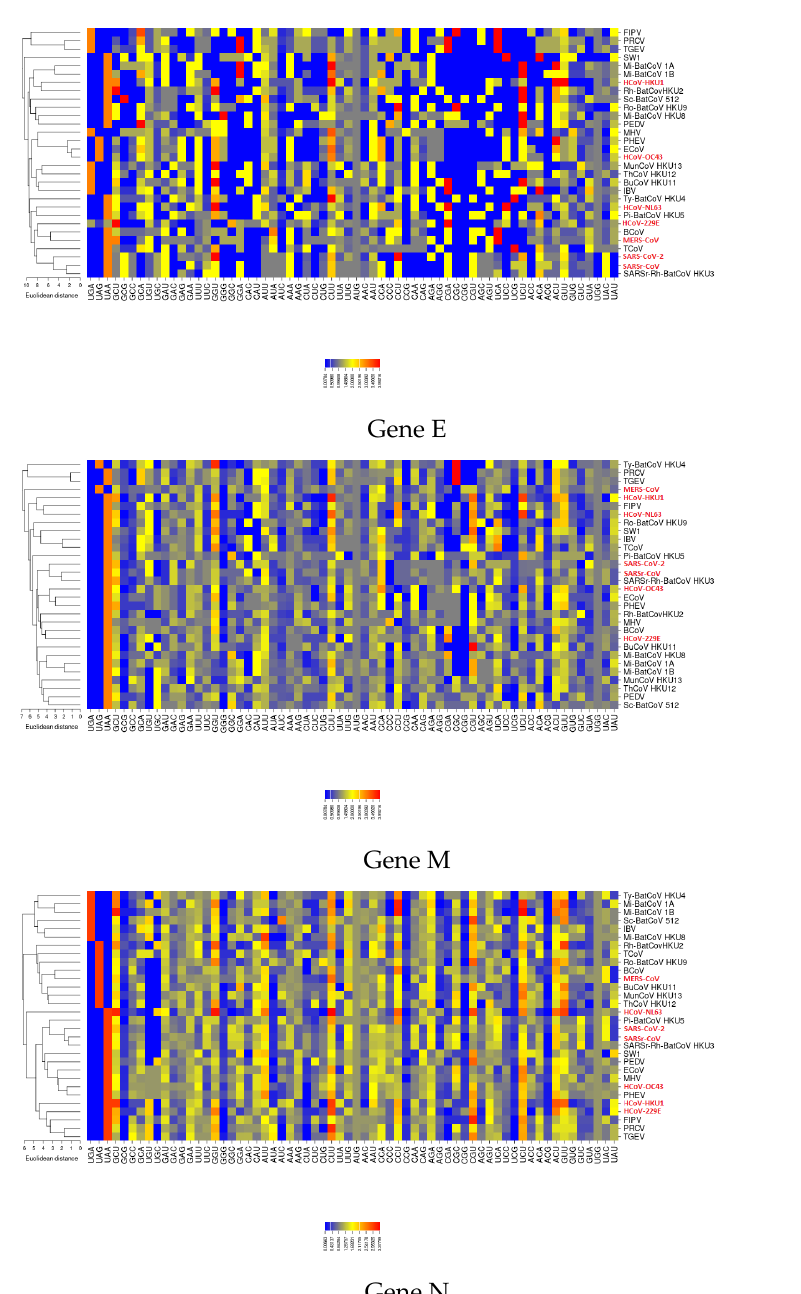
Figure 4. RSCU vectors of three different coronavirus genes. Heatmaps confirm that the RSCU patterns of the newly identified coronavirus SARS-CoV-2 sequence are more related to those of SARSr-CoV and SARSr-Rh-BatCoV HKU3 for genes E, M and N